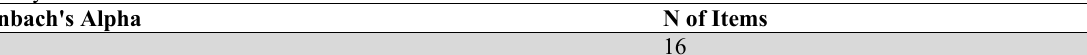
Reliability Statistics